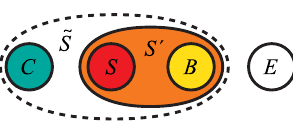
FIG. 1. The systems . The model explicitly includes the “ sys- tem ” S on which we operate, the heat bath B , the control C that implements the change of the Hamiltonian on SB , and the energy reservoir E that donates or accepts the energy required to drive the processes. Most of our fluctuation relations are expressed in terms of the dynamics induced on the energy reservoir E . For the main part of this investigation (Secs. II and III), we assume that the total system is described by a time-independent Hamiltonian that is noninteracting between SBC and E , i.e., is of the form ˆ 1 ⊗ ˆ 1 ⊗ H H ¼ H . We moreover model the evolu- SBC E þ SBC E tion by energy-conserving unitary operators V , i.e., ½ H; V (cid:2) ¼ 0 . (We go beyond these assumptions when we consider approximate fluctuation relations in Sec. VI.) For most of the derivations, it is not necessary to make any distinction between S and B , and for this reason, we often bundle them together into an extended system S 0 ¼ SB . This “ rationalization ” can be taken one step ~ S ¼ S 0 C ¼ SBC when we turn to the conditional further to fluctuation theorems in Sec.